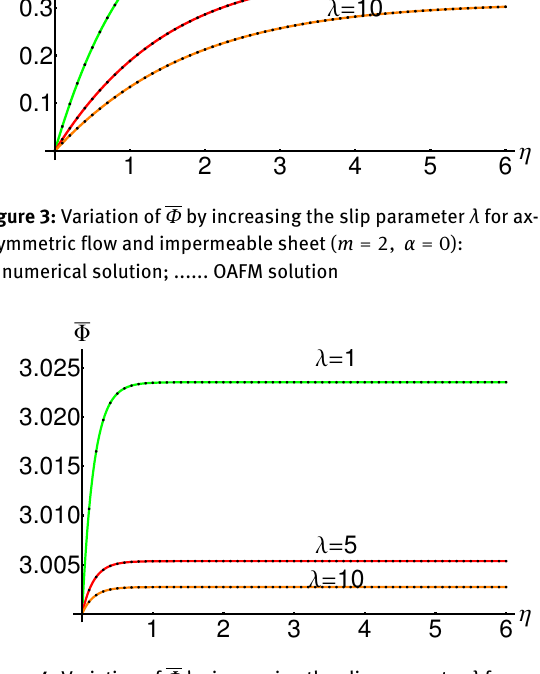
Figure 4: Variation of Φ by increasing the slip parameter λ for ax- isymmetric flow and suction sheet ( m = 2, α = 3) : — numerical solution; ...... OAFM